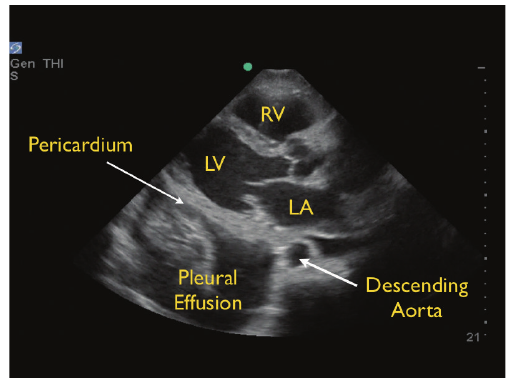
Figure 4: Pleural e ff usion, parasternal long axis view RV: right ventricle, LV: left ventricle, LA: left atrium.